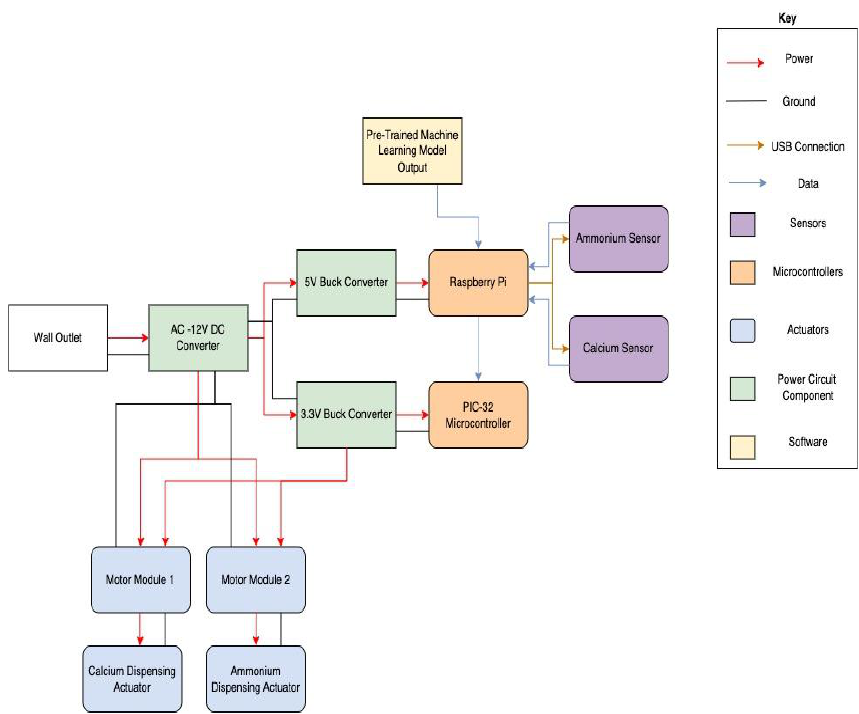
back loop output communicating between the sensor and actuator modules.